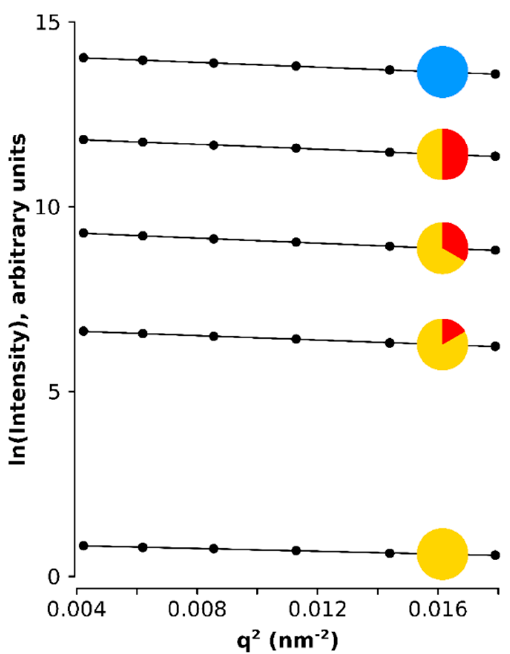
Figure A3. Natural log of the scattering intensity of the SPIONs plotted against the q squared showing the linear dependency which slope is proportional to the radius of gyration.